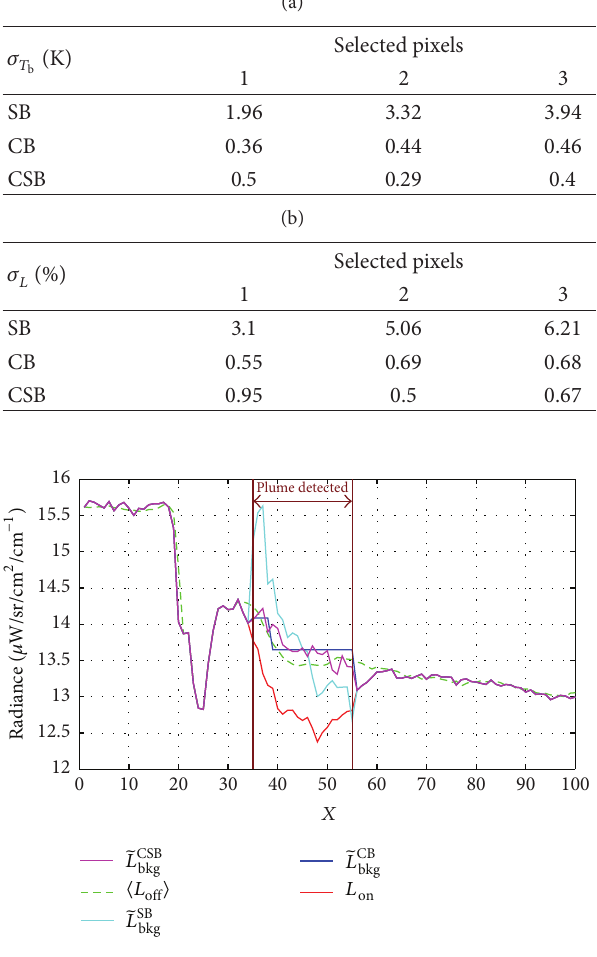
Figure 16: Comparison of different radiances at the ethylene absorptive band ( 950.4 cm −1 ), along a horizontal cross section containing some plume-present pixels. The red curve stands for the on-plume radiances; the green dotted one is the expected back- ground radiances. The cyan, blue, and magenta curves represent, respectively, the background radiances estimated by the SB, CB, and CSB